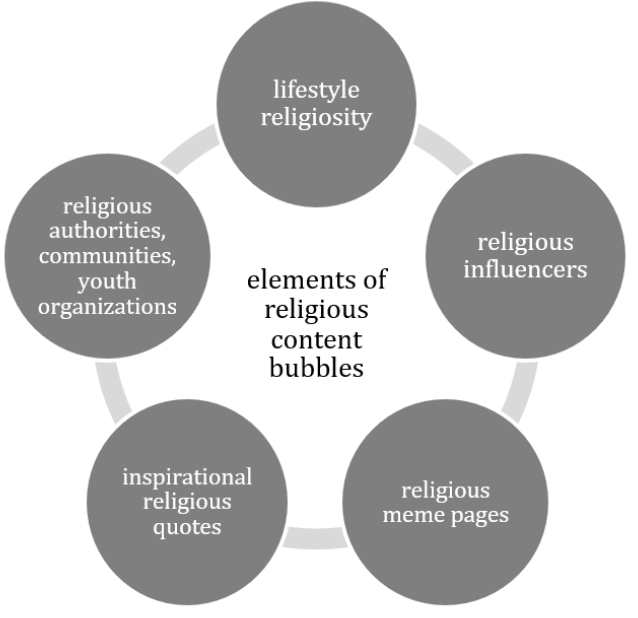
Figure 1. Elements of religious content